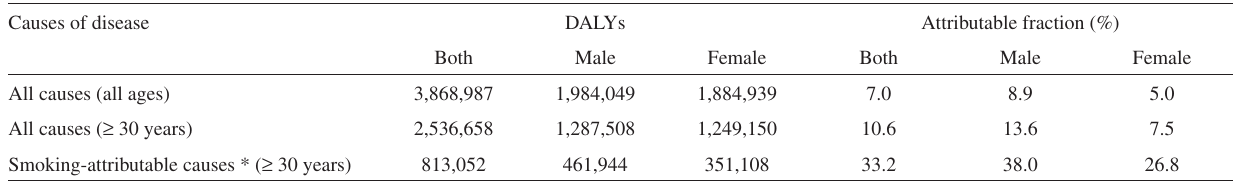
Table 1 - Disability-adjusted life years (DALYs) and their smoking-attributable fraction, according to gender and estimated cause of disease, for individuals (cid:113) 30 years of age. Rio de Janeiro State, Brazil, 2000 Causes of